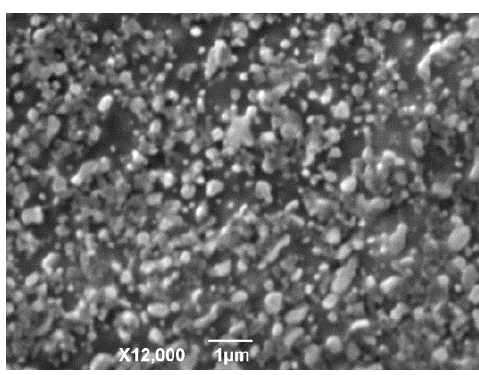
Figure 4. Pictures of secondary phase precipitations after rolling-mill (90%) and annealing for 5 min at 1143 K obtained with the Scanning Electron Microscope.